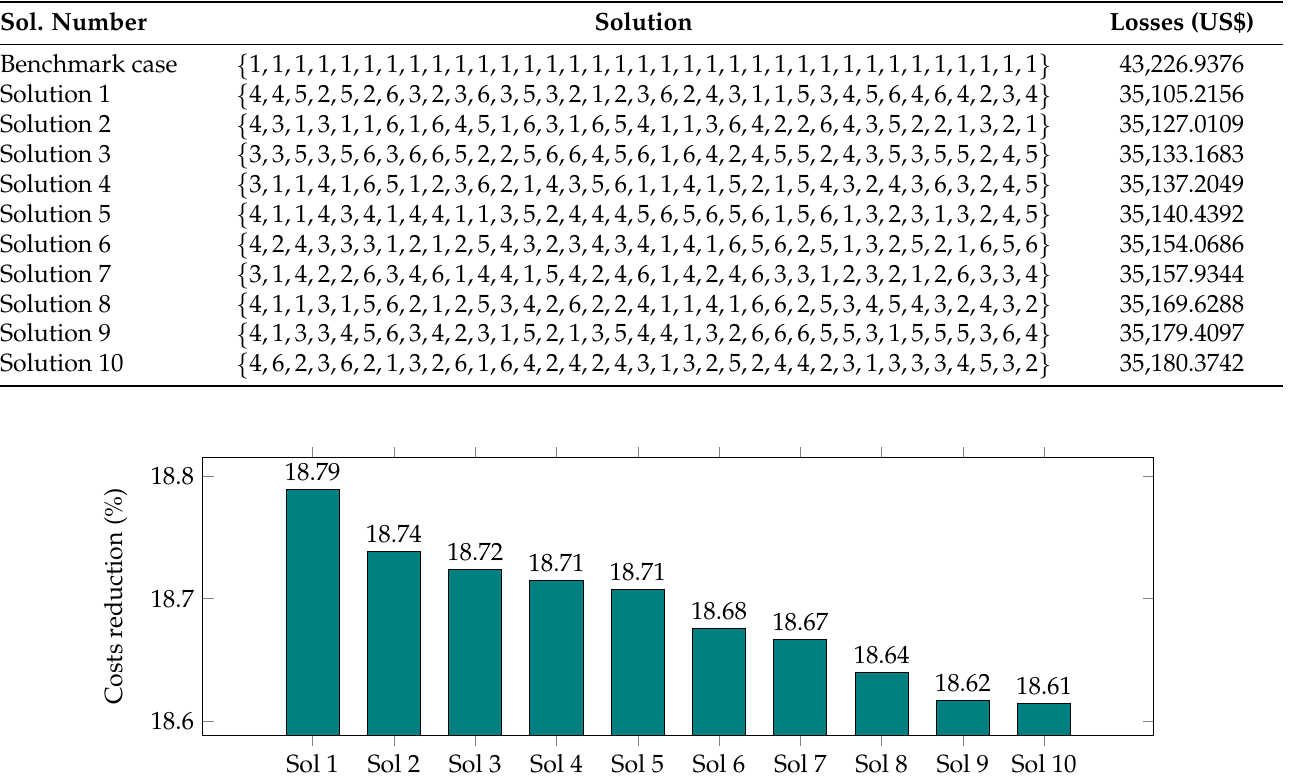
Figure 7. Percentage reduction in annual operative costs for the IEEE 37-bus test system, achieved using the improved CBGA.